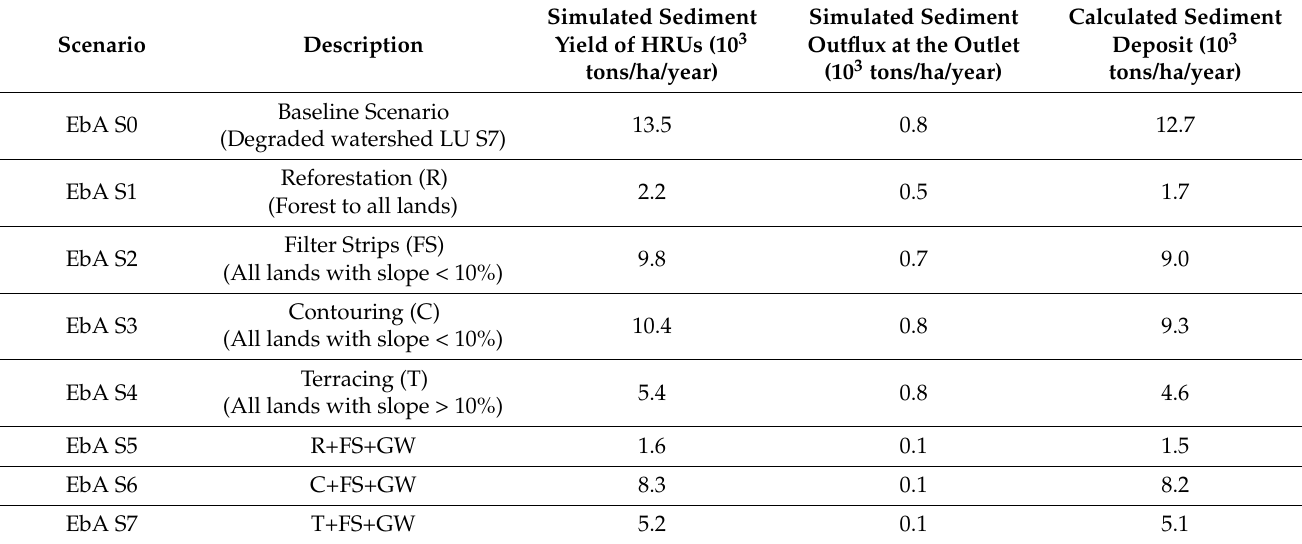
Table 8. Simulated sediment yield of HRUs, simulated sediment outflux at the outlet, and calculated sediment deposition under different EbA